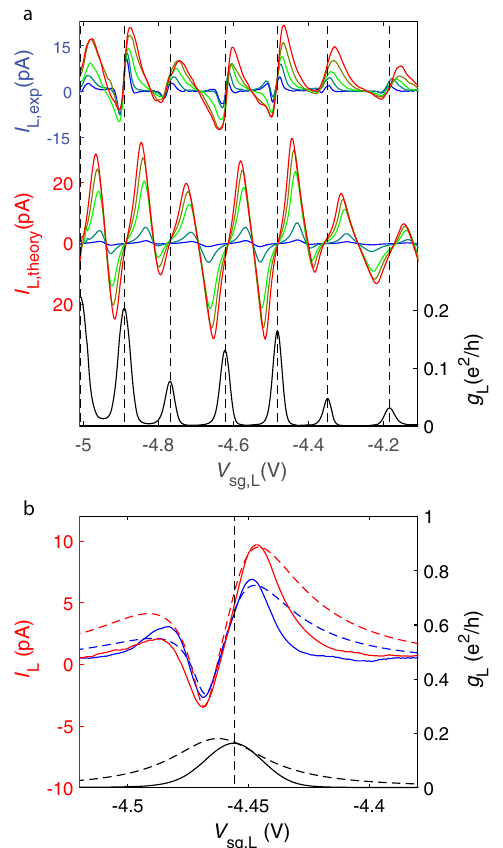
Fig. 4 Drive dependence of thermoelectric current. a Upper curves: thermoelectric current in the left quantum dot I L,exp vs. gate voltage V sg,L measured at heating voltages V h = [5, 9, 19, 25, 29] mV, where V h = 5 mV is the blue curve and 29 mV is the red curve. We estimate the induced temperature difference between the left and right quantum dots to be T L − T R ≃ 17 mK for V h = 5 mV, and T L − T R ≃ 59 mK for V h = 29 mV. Middle curves: theory predictions based on the coherent model (see Supplementary Note 4) for the thermoelectric current I L,theory plotted in the same manner as the upper curves for V h = [5, 10, 20, 25, 30] mV. The gap of Al/Ti leads is set to Δ 0 = 150 μ eV at T = 0 while the BCS gap formula Δ ( T S ) with T S = ( T L + T R )/2 de fi nes the T dependence. Lowest curve: experimental conductance of the left quantum dot. b Incoherent modeling for the low temperature regime: theoretical fi ts (dashed) to the measured thermoelectric currents I L and conductance g L (solid) at V h = 7 and 11 mV, blue and red curves, respectively. The model is based on the assumption that the system may be split into the coherent subsystems, which, in turn, are joined incoherently into a circuit. Details of the model and fi tting parameters are given in Supplementary Note